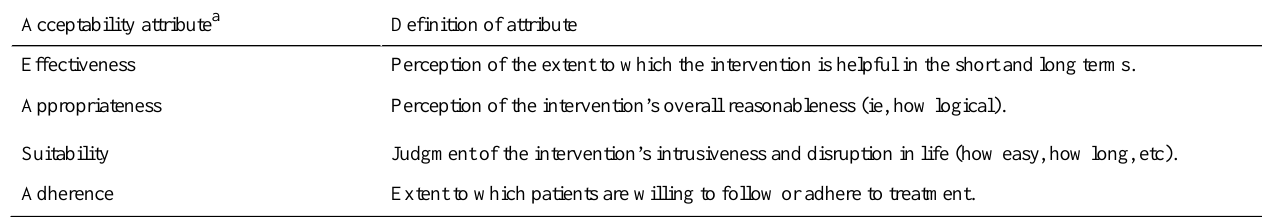
Table 1. Definitions of acceptability attributes of the TAP measure